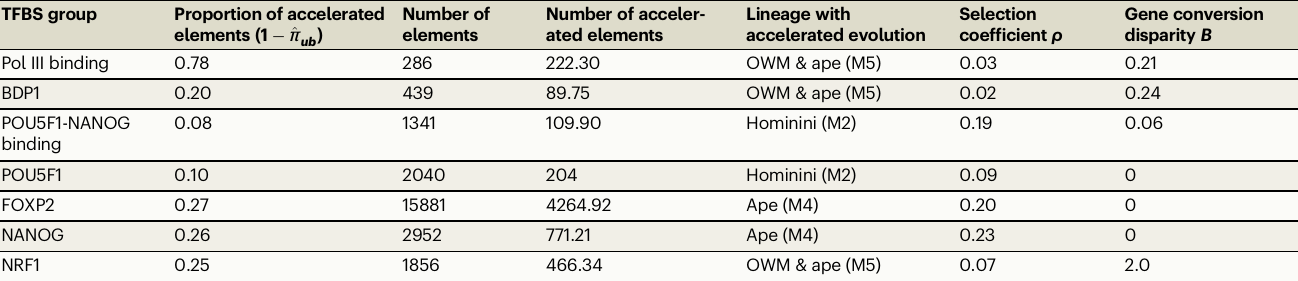
Table 1 | Numbers of accelerated TFBSs estimated by the phylogenetic mixture model TFBS group Proportion of accelerated elements (1 (cid:1) ^ π ub )